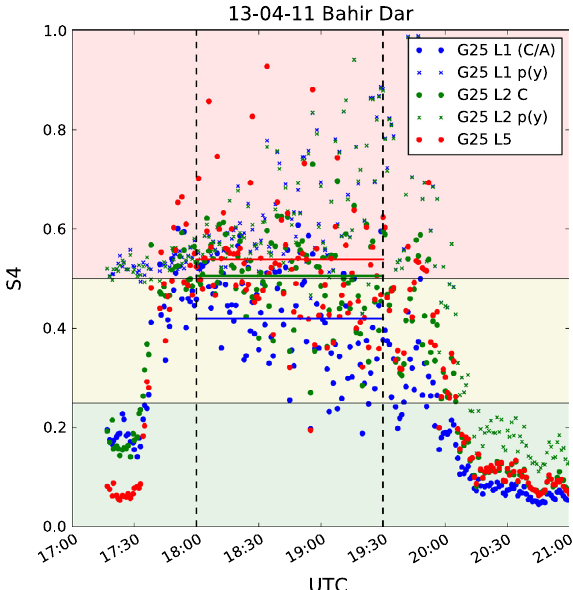
Figure 2. Comparison of the scintillation index S 4 for the different signals of GPS satellite 25 at the 11th April 2013 in Bahir Dar, Ethiopia. The colored solid lines are averages of the S 4 value in the time interval [18:00, 19:30]